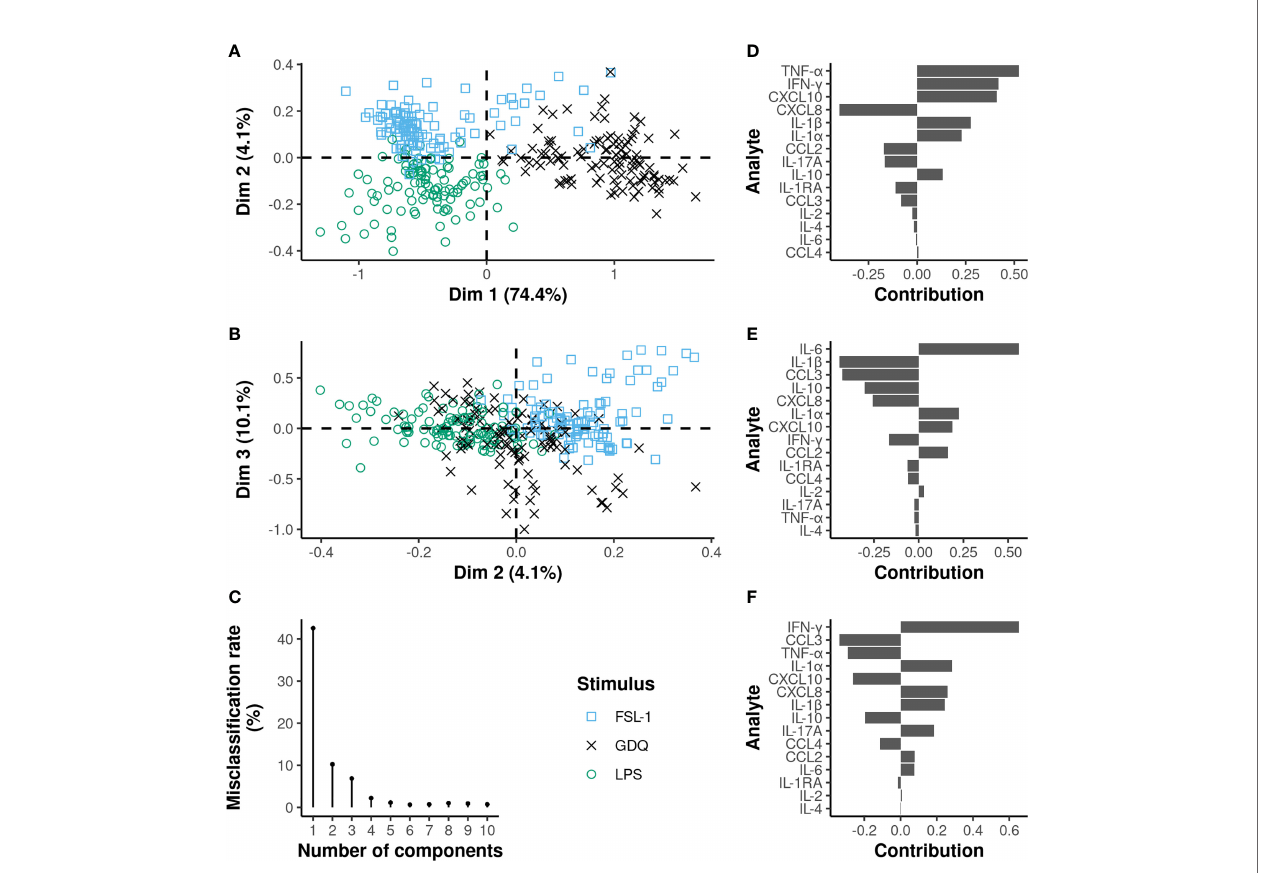
FIGURE 6 | Multilevel PLS-DA on TLR ligands adjusted MFI values identi fi es commonalities between TLR2/6 and TLR4 engagements. On the plots of the individuals (A, B) , each dot represents an individual cow and the corresponding stimulus is de fi ned by the different colors and shapes. The x and y-axis correspond to the PLS-DA components. The proportion of variance explained by each principal component is written in brackets. The contribution of the cytokines to the fi rst (D) , second (E) and third (F) principal components are represented by a horizontal barplot. The three fi rst principal components are suf fi cient to reach a misclassi fi cation rate below 10% (C)